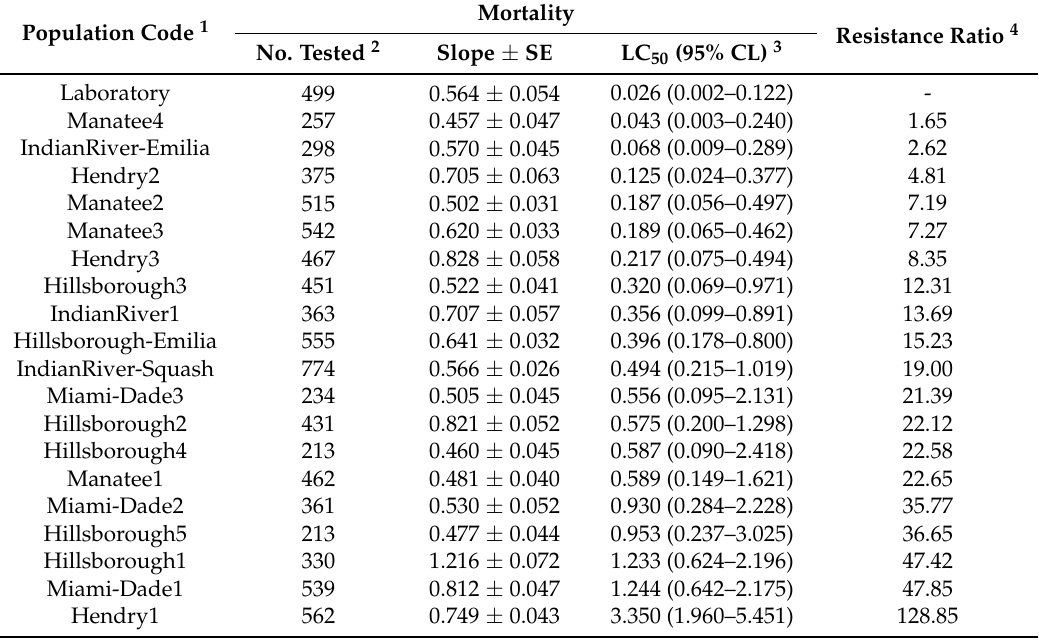
Table 3. Dose response to dinoteturan and resistance ratios of Bemisia tabaci adults, reared from Florida field-collected populations, as measured by mortality (LC 50 ) with a cut cotton leaf and petiole systemic uptake bioassay in the